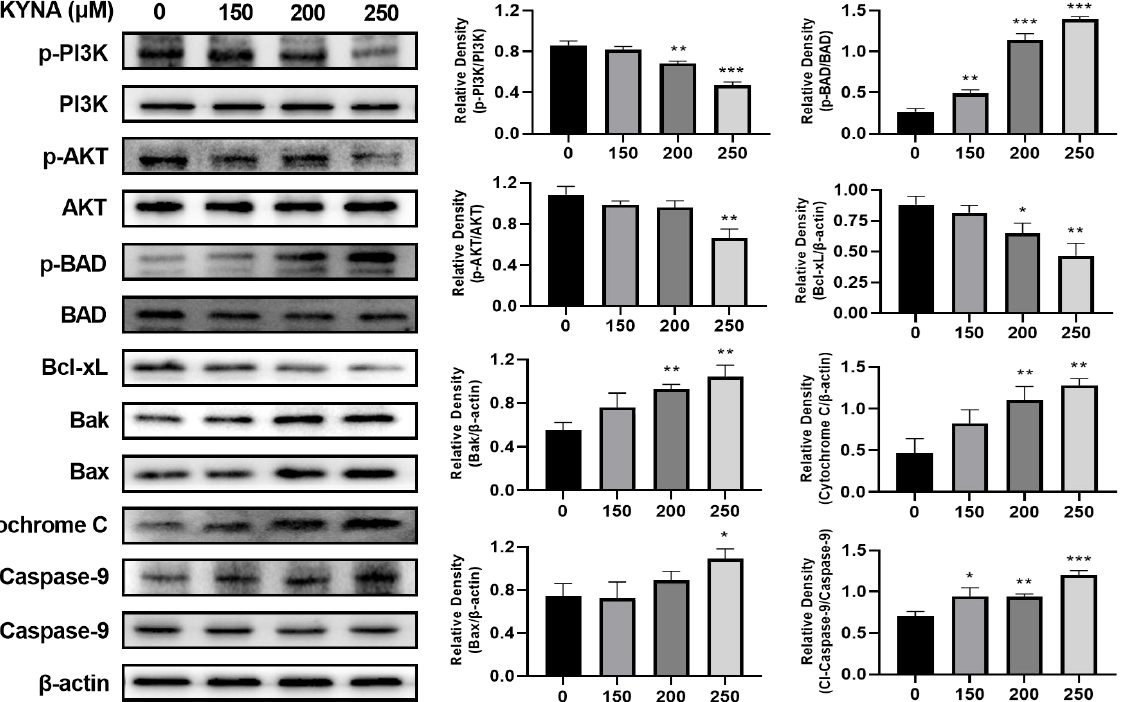
Figure 9. KYNA induced intrinsic apoptosis pathway in AGS cells. The cells were treated with KYNA at indicated concentrations (0, 150, 200, and 250 µ M) for 24 h. P-phosphoinositide 3-kinase (p-PI3K), p-protein kinase B (p-AKT), Bcl-2-associated death promoter (BAD), Bcl-xL Bak, Bax, Cytochrome C, and cleaved caspase-9 levels were quantified by western blot. The results obtained from three independent experiments were expressed as mean ± standard error of the mean (SEM) compared with the control group. * p < 0.05, ** p < 0.01, *** p < 0.001.